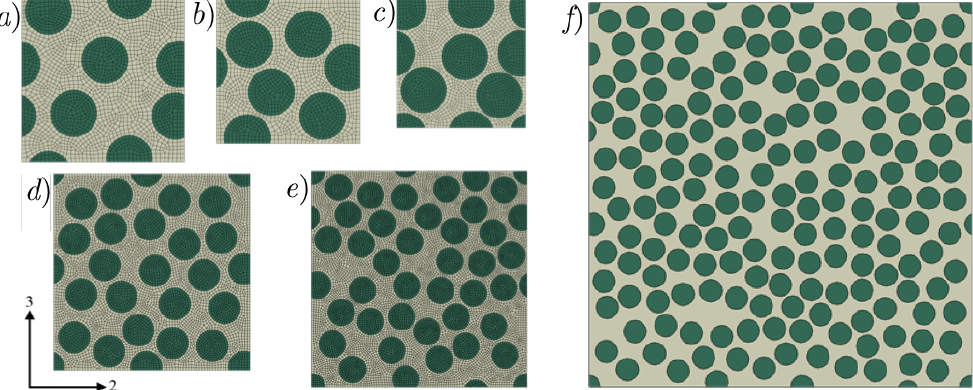
Figure 5. Types of randomly packed fiber unit cells: ( a ) six-fiber unit cell ( V unit cell ( V f = 0.5), ( c ) six-fiber unit cell ( V f = 0.6), ( d ) 24-fiber unit cell ( V f = 0.5), ( e ) 40-fiber unit cell ( V f = 0.5) and ( f ) 180-fiber unit cell ( V f = 0.5). For each type of unit cell shown above, 10 different realizations of randomly packed fiber configurations are